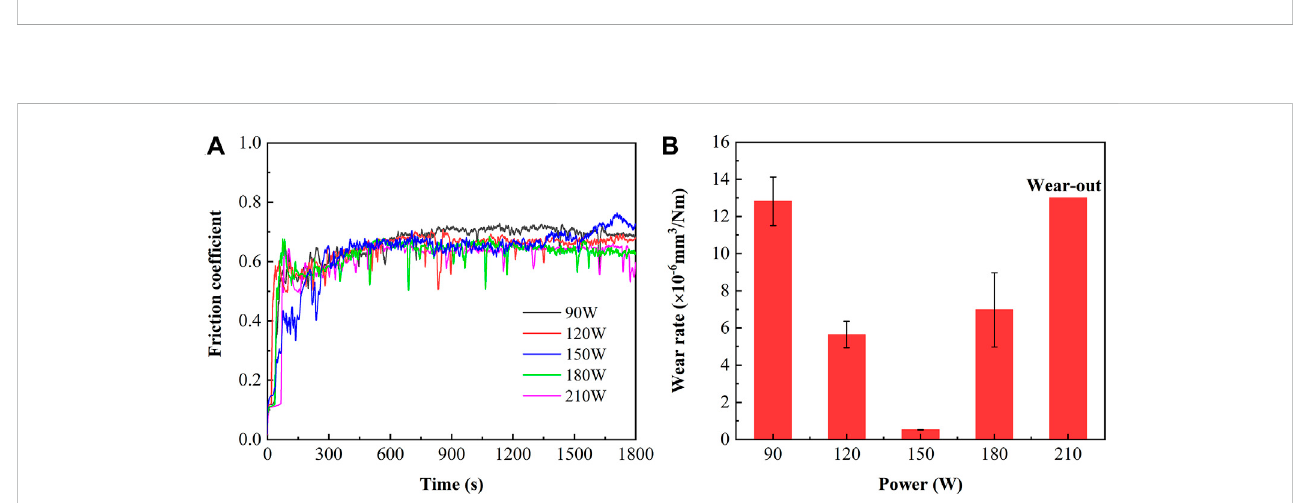
FIGURE 9 Surface morphologies of the scratch tracks for the ZrNbTiMo RHEA fi lms deposited at different sputtering power: (A) 90 W, (B) 120 W, (C) 150 W, (D) 180 W, and (E) 210 W.